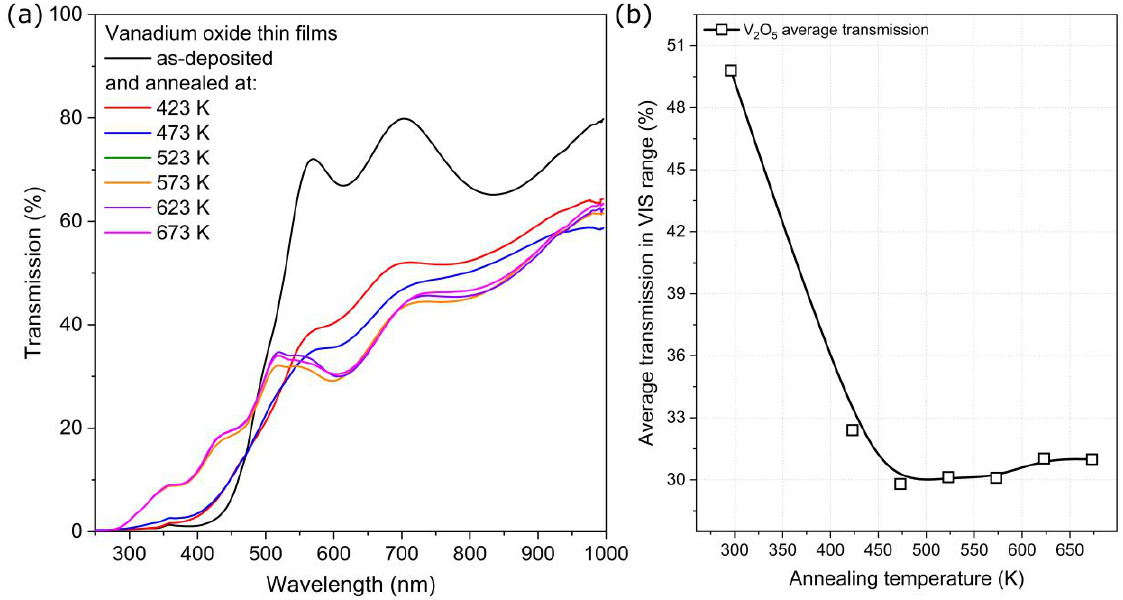
Figure 4. Results of: ( a ) transmission spectra of V 2 O 5 thin films annealed at various temperatures and ( b ) the average transmission of vanadium oxides in the VIS wavelength range. and ( b ) the average transmission of vanadium oxides in the VIS wavelength